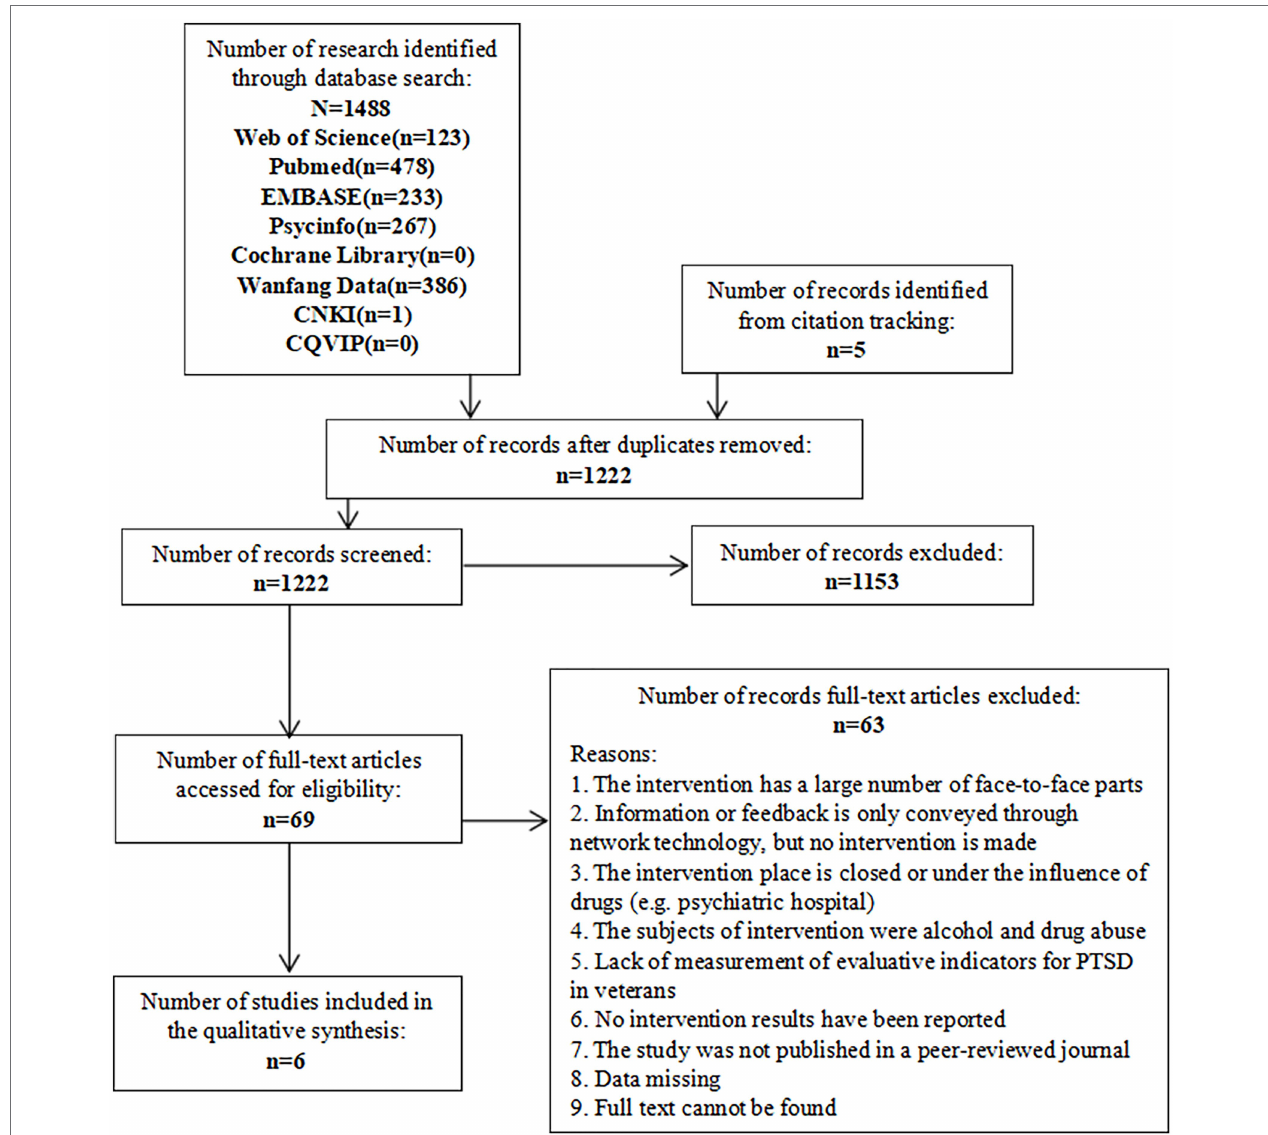
FIGURE 1 | PRISMA diagram of included studies in the